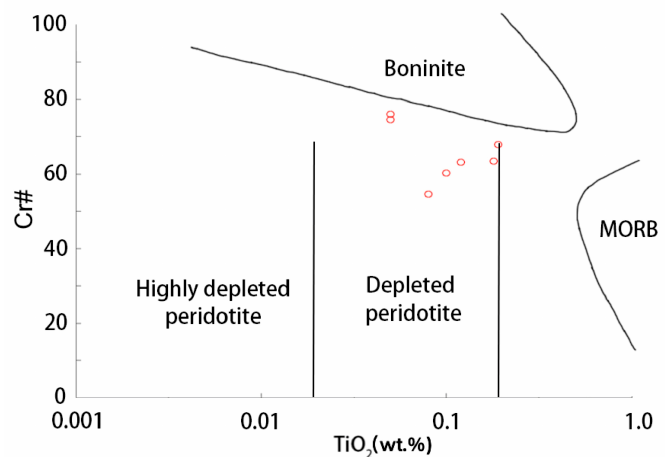
Figure 11. Cr-TiO 2 discriminant graph of Chromite in “Laoshan Jade” [53].